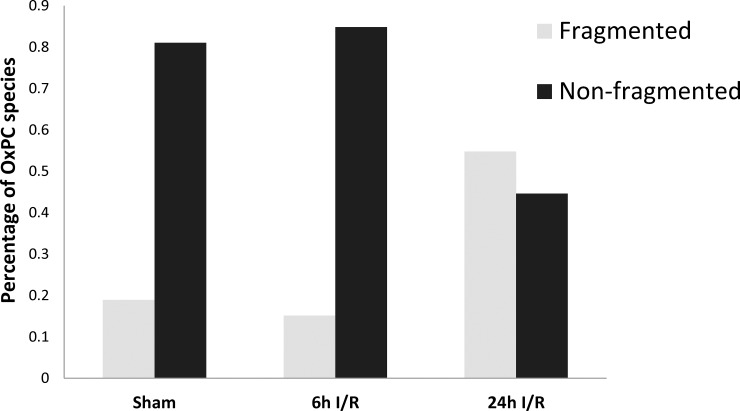
Percent of total OxPC in rat kidney in sham and I/R groups.Values represent the average relative percentage of a particular OxPC species compared to the total OxPC. n = 4 in each group, OxPC: Oxidized phosphatidylcholine.